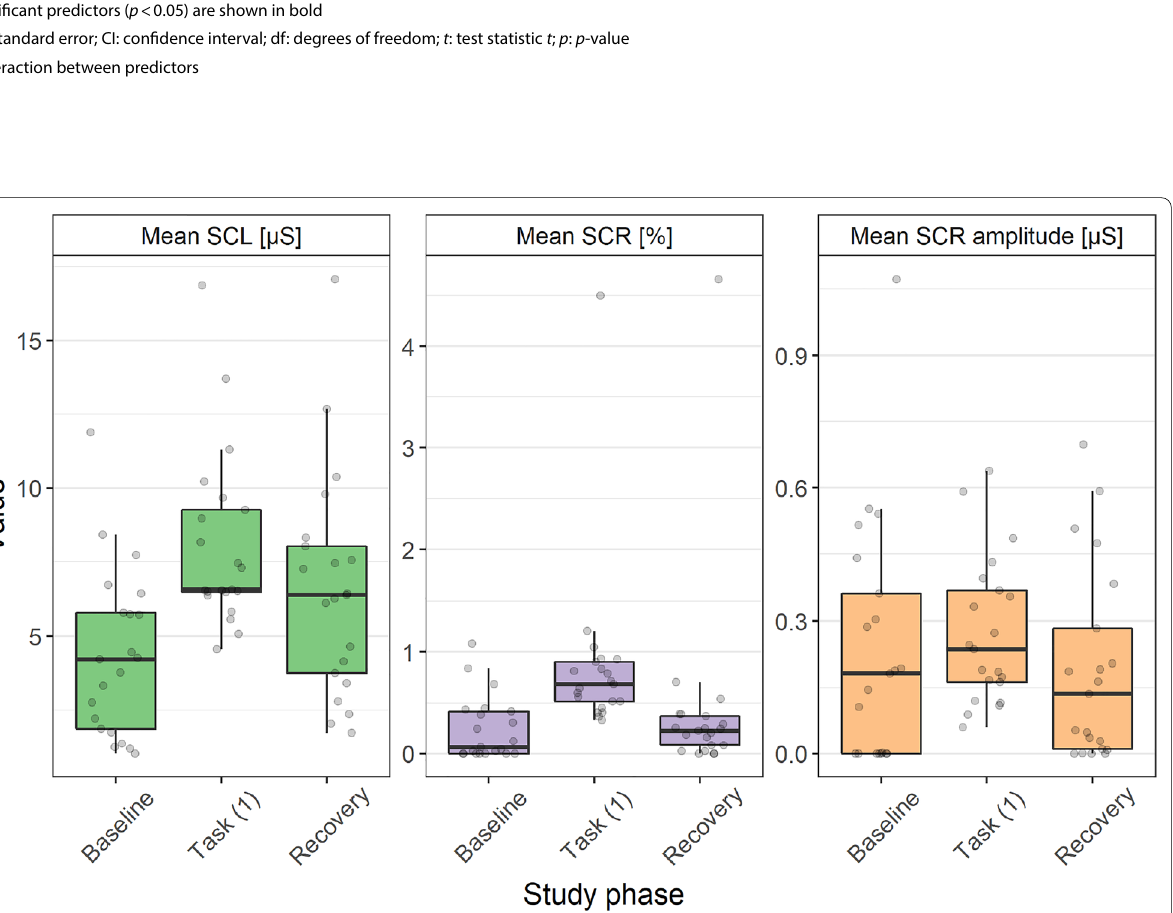
Significant predictors ( p < 0.05) are shown in bold